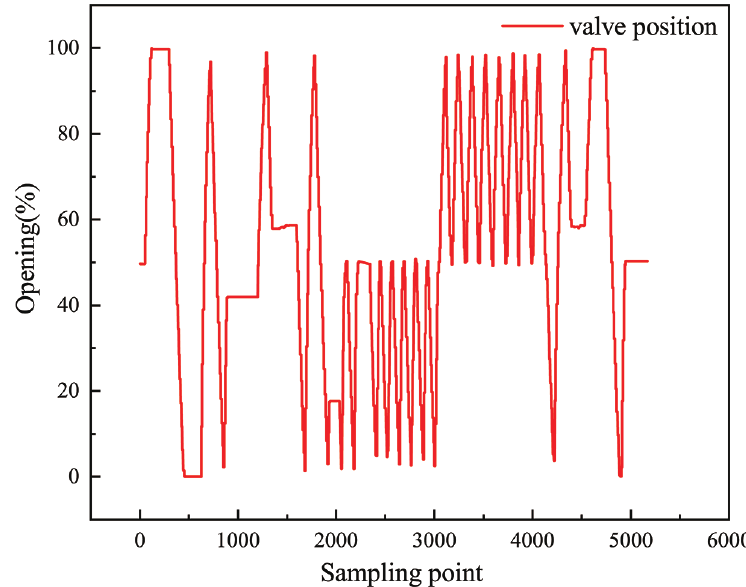
Figure 6. Identification process of parameter